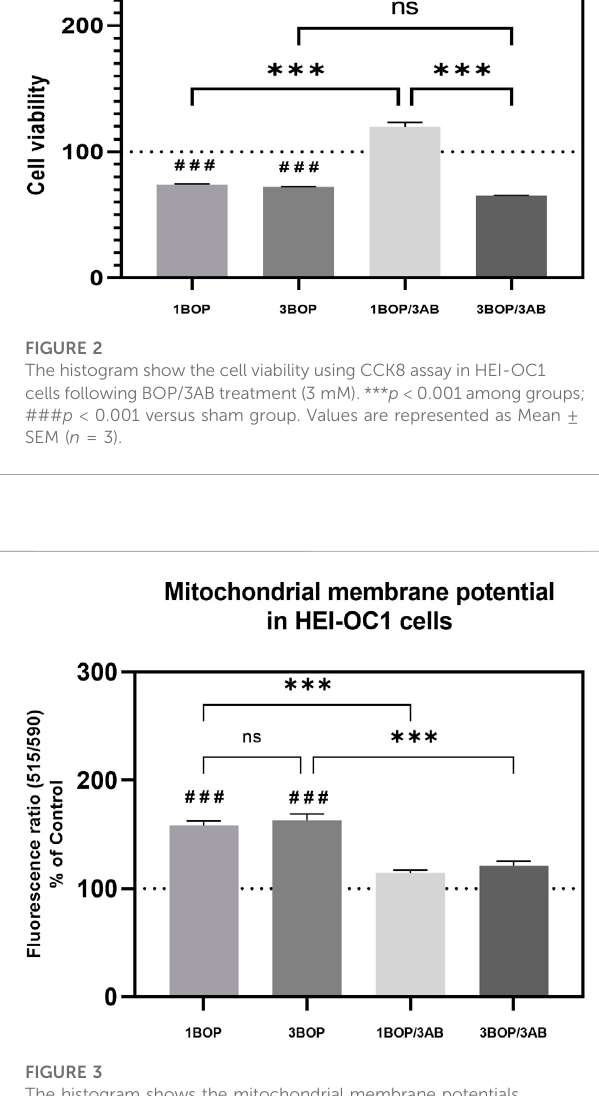
The histogram shows the mitochondrial membrane potentials usingJC10assayinHEI-OC1cellsfollowingBOP/3ABtreatment(3 mM). *** p < 0.001 among groups; ### p < 0.001 versus sham. Values are represented as Mean ± SEM ( n =